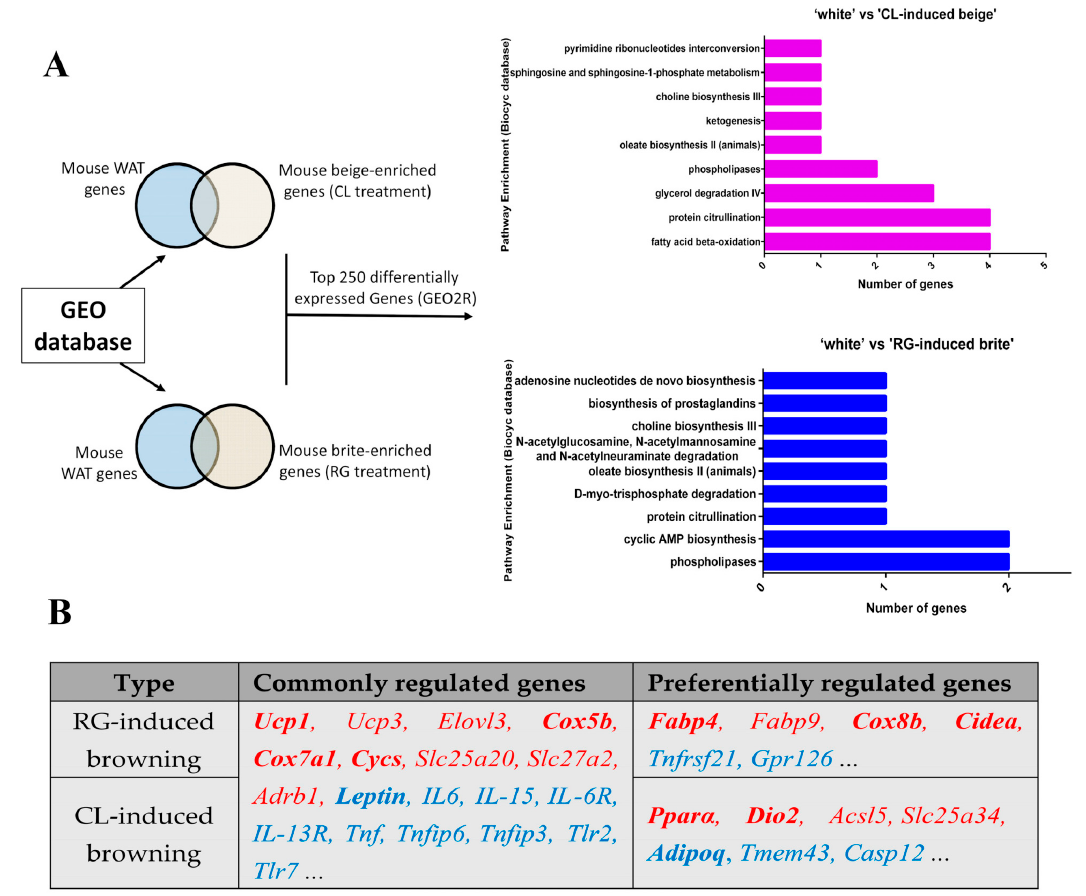
Figure 5. The unique regulatory roles of CL316,243 and rosiglitazone in adipocyte browning process. ( A ) CL316,243 and rosiglitazone preferentially activates different metabolic pathways involved in adipocyte browning (Common pathways: phospholipase, protein citrullination, and oleate/choline biosynthesis; Preferential pathways: CL-induced fatty acid β -oxidation, RG-induced cAMP biosynthesis); ( B ) Commonly and preferentially regulated genes of RG-induced browning and CL-induced browning from dataset GSE87,191 (gene names in red represent upregulating genes, while those in blue represent downregulating genes, and gene names in bold have been checked in our study).